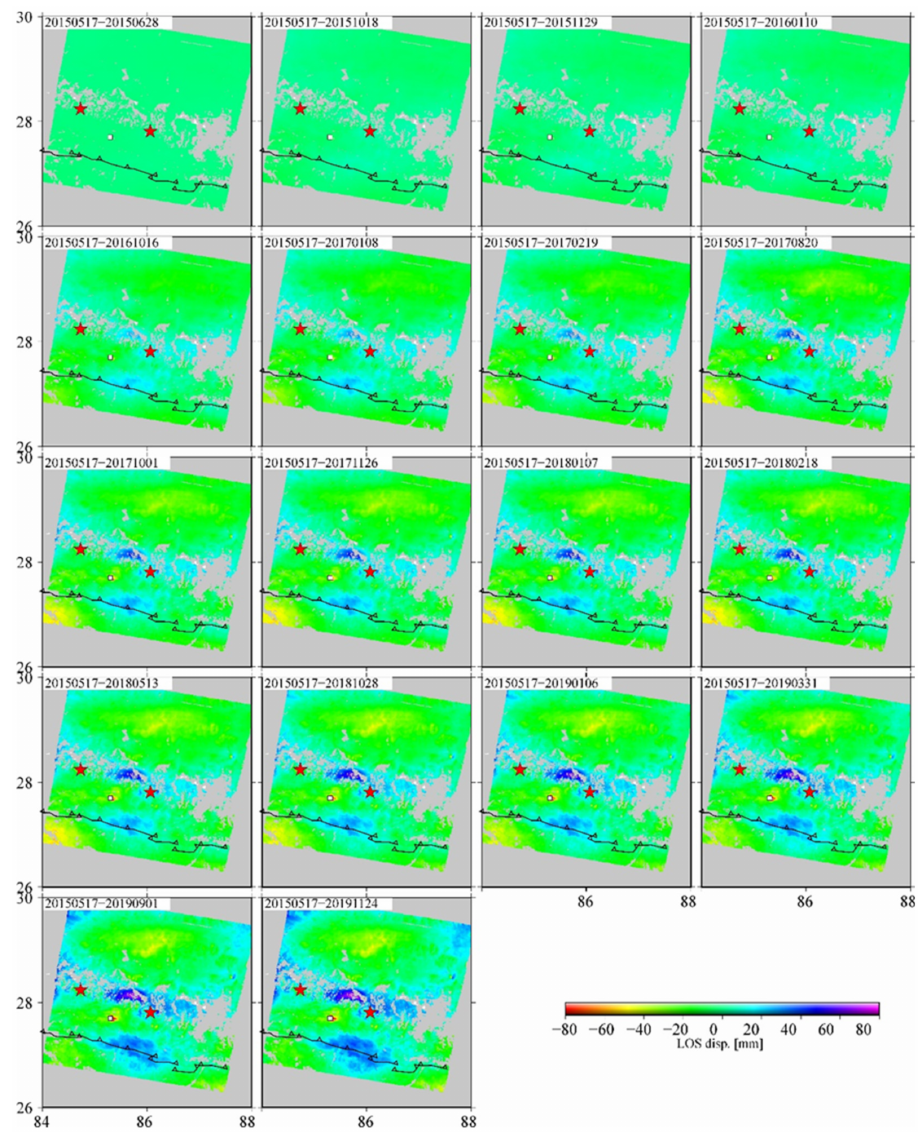
Figure 6. Post-seismic deformation time series of the 4.5 yr after the Nepal Mw 7.8 earthquake, the red star represents the epicenter of the Mw 7.8 and Mw 7.3 earthquakes; the black lines indicate the surface of the MFT; the small white box shows the location of